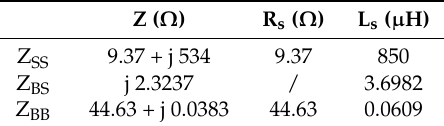
Table 2. Calculated values of Z-Matrix.